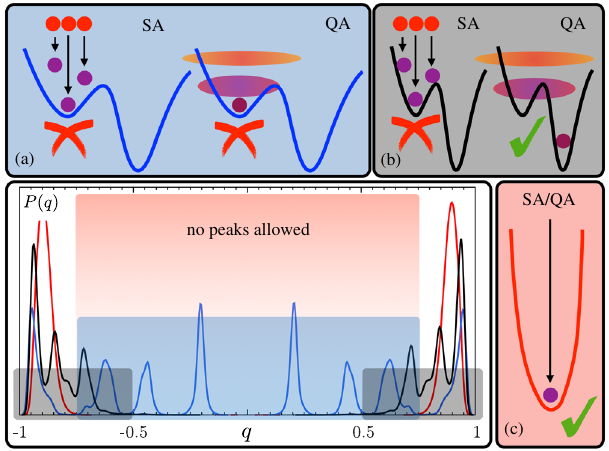
FIG. 1. Main panel: Overlap distribution P ð q Þ for three char- acteristic disorder instances. For the hard instances with thick barriers, we choose instances in the central [blue (dark)] box that have features that extend outside this domain. Based on classical simulations, we expect these instances to be on average among the hardest. In (a), we show the expected outcome of experiments with both simulated annealing (SA) and quantum annealing on the DW2 device (QA). Because the barriers are large and thick, we expect both classical and quantum approaches to have difficulties. In (b), we illustrate the expected behavior when the barriers are thin, i.e., double peaks (or more) that protrude from the dark boxes in the region j q j > 0 . 5 . The features in the energy landscape of these hard instances with thin barriers are still very pronounced, but we expect the barriers to be thinner than in (a). While SA should show little to no advantage when the barriers remain high but are thinner, if the DW2 device has any quantum advantage, it might be able to overcome these barriers. Finally, we study instances that have no features for j q j < 0 . 75 (large red box in the main panel) and only have a single peak at (cid:2) q . These (hard) EA instances with small barriers have the simplest energy landscape (c) with mostly only one dominant feature. As such, we expect any annealing approach to efficiently find the optimum of the problem (on average). Note that these are cartoons intended to illustrate the different instance classes and do not represent actual